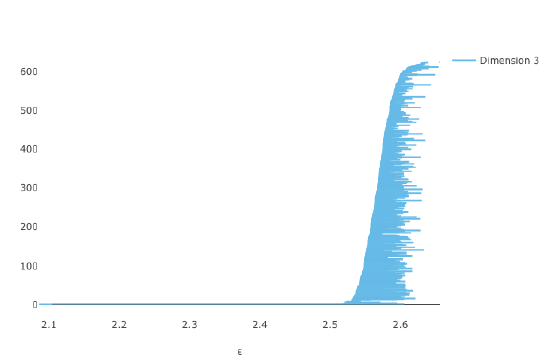
Figure 10. The H 3 barcode for 200 points on R P 3